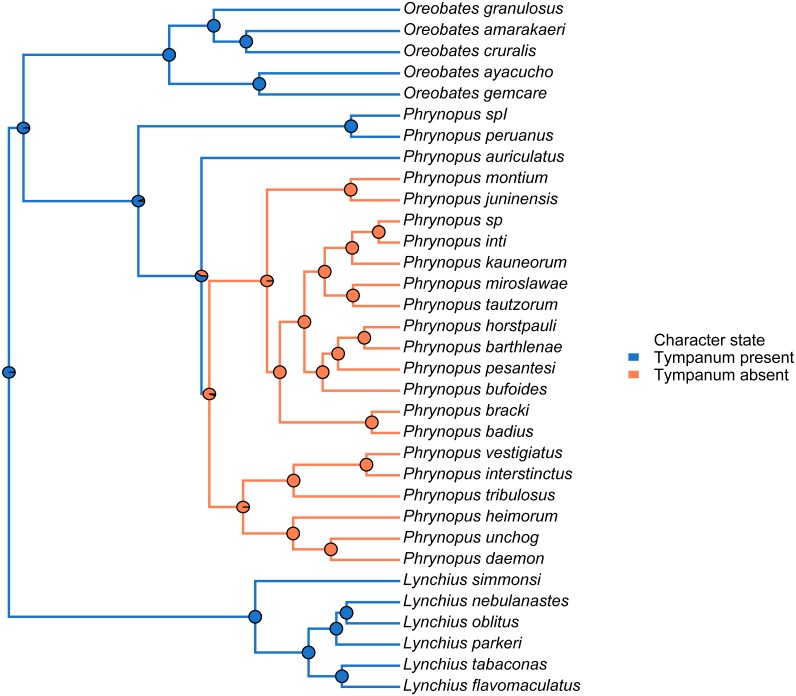
Stochastic mapping tree.Species tree of Phrynopus species included in this study, and representative species of Lynchius and Oreobates, with a sample stochastic character map of tympanum condition (blue indicates presence and orange indicates absence of tympanic annulus) and ancestral state estimates from 500 simmaps indicated at the nodes.